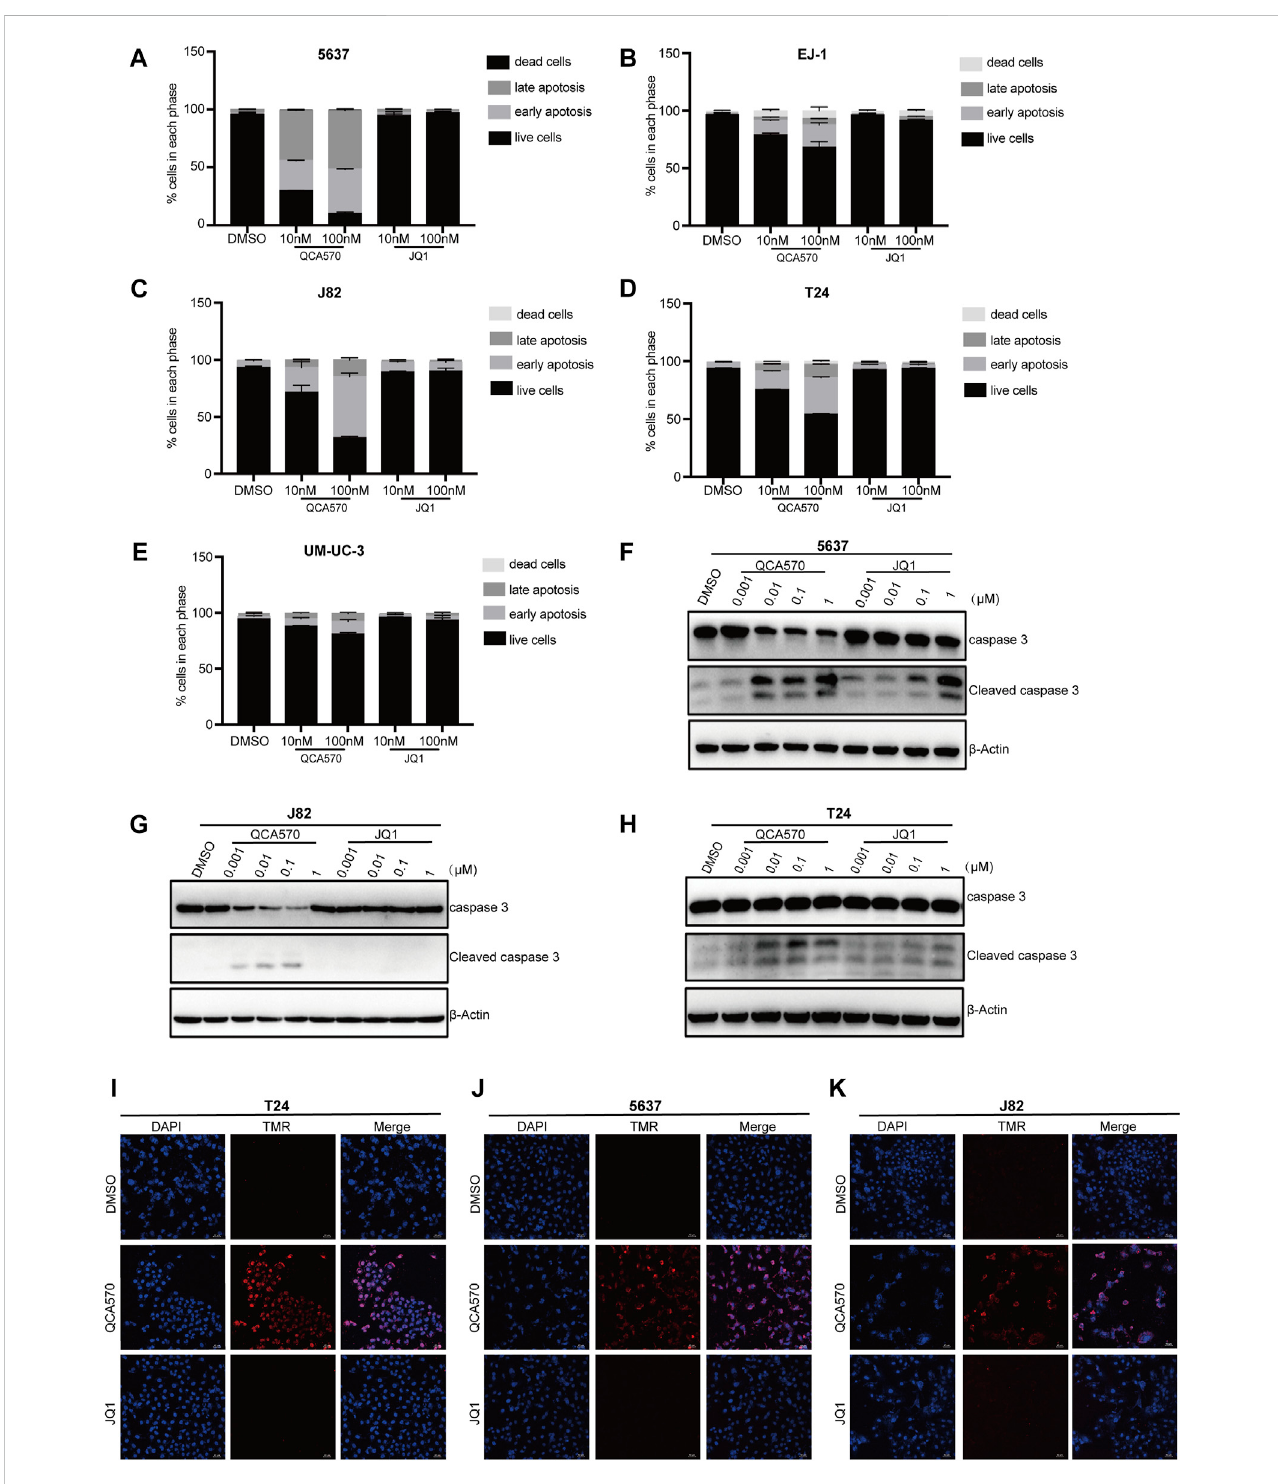
FIGURE 5 QCA570 induced cell apoptosis and cell cycle arrest (A – E) EJ-1, 5637, J82, UMUC-3 and T24 cells were treated with QCA570 or JQ1 for 72 h, and cell apoptosis was determined by Annexin V-FITC/PI staining and fl ow cytometry. Percentages of apoptosis cells were plotted using GraphPad Prism 9.0. Data werepresentedasmeans±SEM. (F – H) 5637,J82andT24cellsweretreatedwithdifferentconcentrationsofQCA570orJQ1for72 h.Westernblotanalysisof the expression of cleaved caspase-3. (I – K) Apoptosis was analyzed by TUNEL staining. The red dots represented apoptotic cells, and DAPI (blue) indicated cell nuclei. Magni fi cation, ×